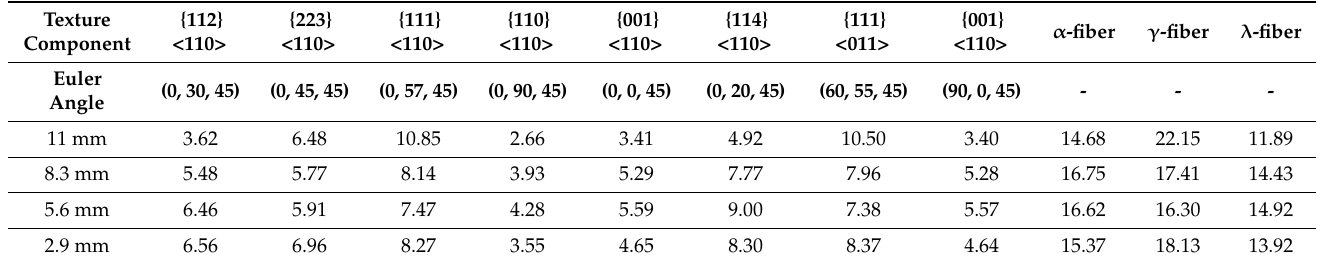
Figure 10. Orientation density distribution along various orientation lines in the forged tube with a reduction of 42.7%: ( a ) α -fiber orientation; ( b ) γ -fiber orientation; ( c ) λ -fiber orientation.